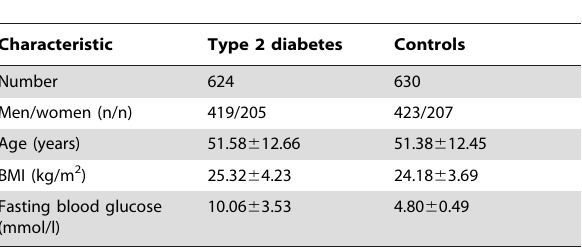
Table 1. Clinical characteristics of the study